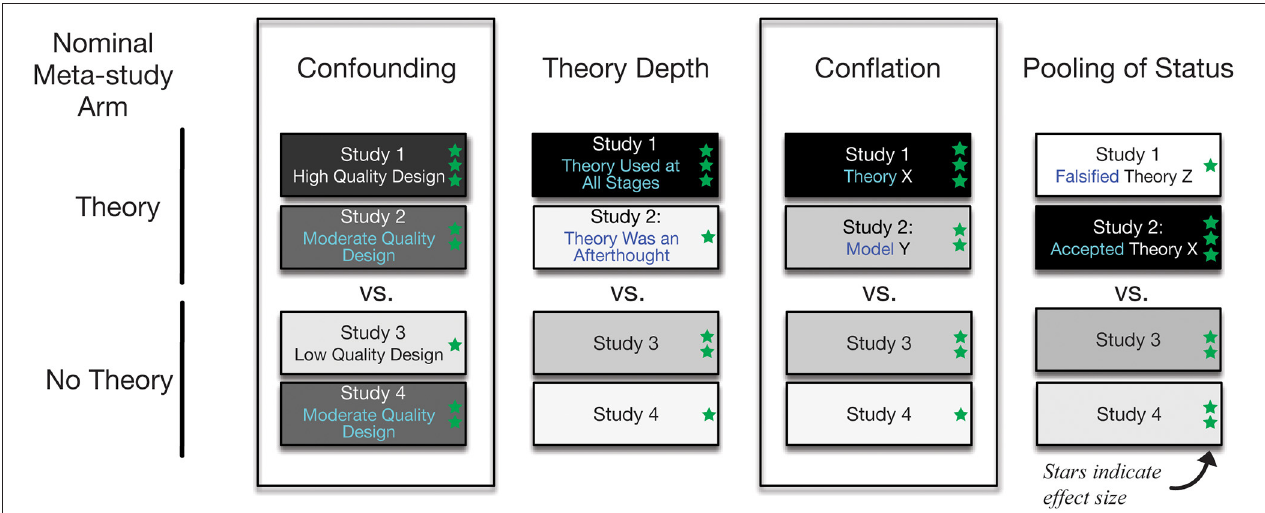
FIGURE 1 | Diagrammatic representations of potential explanations for weak estimated effects attributed to theory in meta-analyses. The diagram provides a visualization of four hypothetical scenarios where a comparison is made between a set of theory-based studies vs. a set that did not use theory. Each box represents one study. The number of green stars and the darkness of the fill represents stronger estimated treatment effects. In each hypothetical scenario, the overall effect in the theory study arm may be attenuated by either confounding, imprecise measurement, conflation, or status pooling. In the example confounding scenario, studies that use theory also have a higher quality experimental design; the effects in Study 3 may be underestimated as an artifact of poor design features. The theory depth scenario exemplifies the situation where theory is invoked in a study, but it was not used in the intervention design, so studies that used theory throughout the intervention development are combined with those that only invoke theory in the research report. In the conflation scenario, studies based on models are treated as being theory-based, so theories are pooled with other types of scientific representations. In the pooling of status scenario, studies using theories that are poor fits to the context or have been demonstrated to be inferior for the particular application and proposed theories are pooled with accepted theories that have been successful and severely tested in the domain of